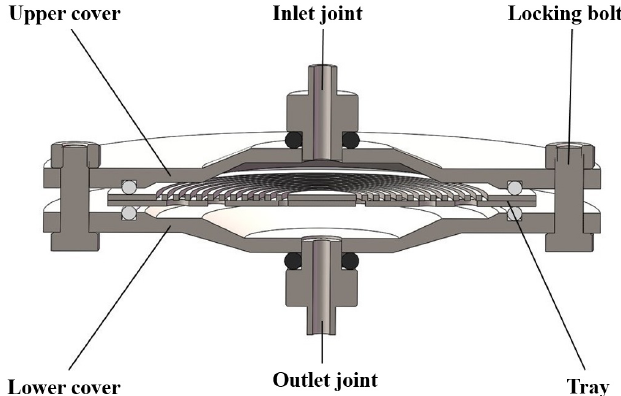
Figure 3. The physical figure of the plate